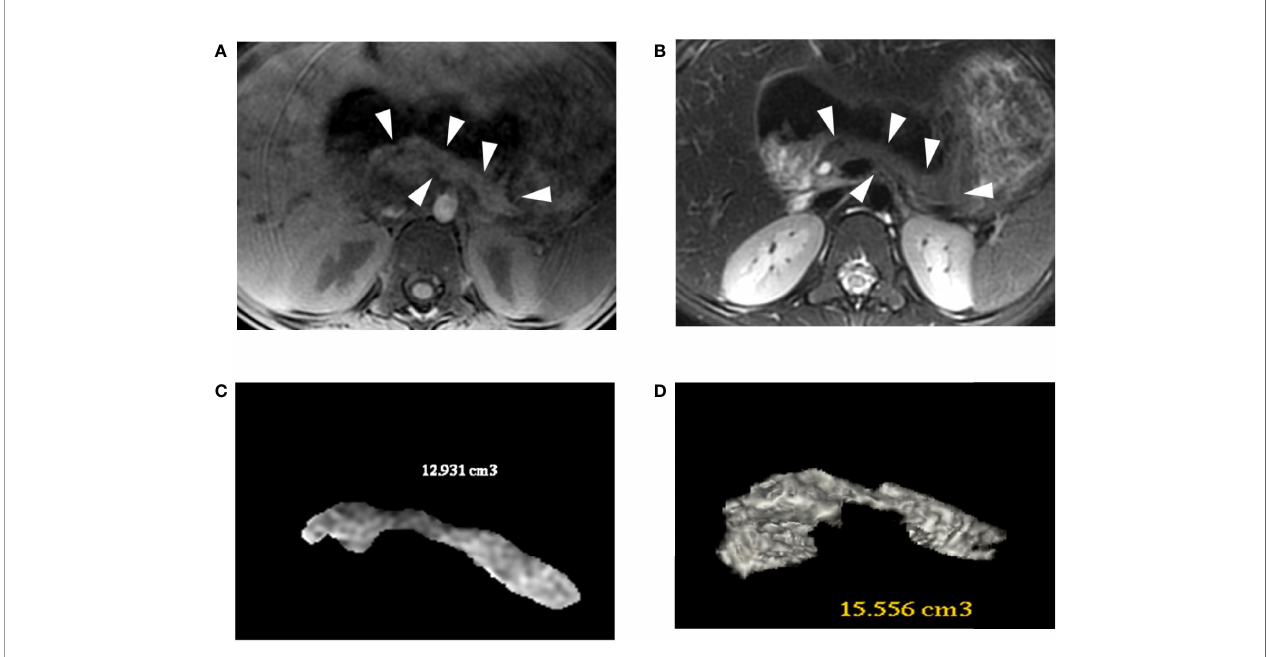
FIGURE 4 | Patient 2 (R181W) 3D-MRJ T2 (A) and Tl-weighted (B) with volume rendering reconstructions (C, D) . The MRI shows a small pancreas (white arrowheads), especially in the bod y and tail, with a volume estimated between 13 and 15.5 cc. For comparison, an aged-matched control patient has a pancreatic volume of 45